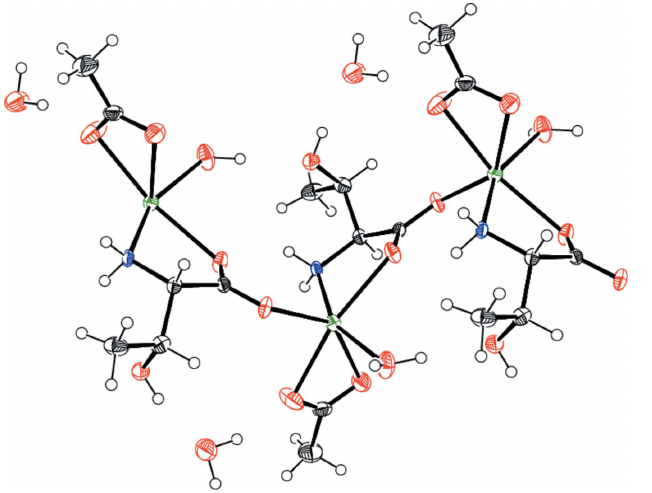
Figure 2 The polymeric structure of the title compound.